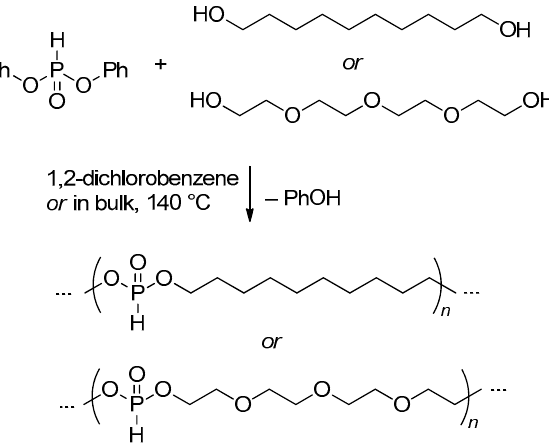
Scheme 5. Polycondensation of diphenyl phosphonate with diols [54]. To obtain PCPAs, PEG200- and PEG1000-based poly(alkylene phosphonate)s were oxidized by N 2 O 4 in CH 2 Cl 2 [24]. The same reagent was also used for the oxidation of block copolymers mPEG750- b -[(P(O)(H)O(CH 2 ) 6 ] 17 - b -mPEG750 and mPEG2000- b -[(P(O)(H)O (CH 2 ) 6 ] 17 - b -mPEG2000 in CH 2 Cl 2 at − 10 ◦ C [53] and poly(1,2-propylene glycol)-based poly(alkylene phosphonate)s [28]. Chlorination of poly(alkylene phosphonate)s at 0 °C resulted in the formation of poly(alkylene chlorophosphate)s that can be easily hydrolyzed with a formation of PCPAs [54] (Scheme 6a) or transformed into alkoxy- [23] and amino-derivatives [55] (Scheme 6b). The degree of chlorination of poly(alkylene phosphonate)s can be varied when using trichloroisocyanuric acid as the chlorination reagent; the quantitative yield of the corresponding PCPA was confirmed by NMR monitoring of the hydrolysis of MeO[P(O)(Cl)O (CH 2 CH 2 O) 9 ] 28 H in MeCN (full conversion after 15 min at 20 ◦ C) [26].